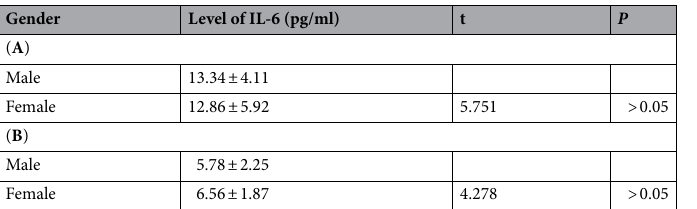
Table 6. No difference of IL-6 expression was detected between in male or female specimens. (A) Relative levels of FER1L4 expression in male or female OA patients. (B) Relative levels of FER1L4 expression in male or female healthy controls. * P < 0.05.